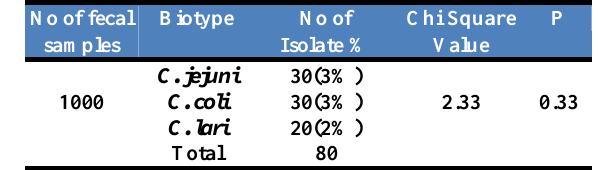
Table, 2: Percentages of Campylobacter in Baghdad